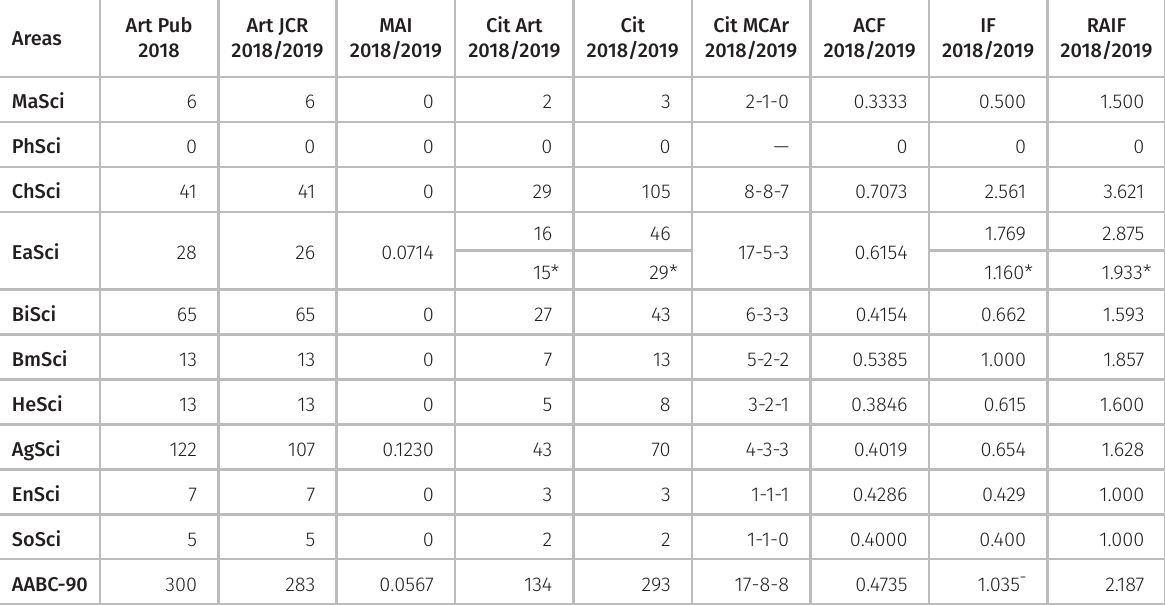
Table I. Scientific fields, citations and indexes concerning the articles published by the Annals of the Brazilian Academy of Sciences in